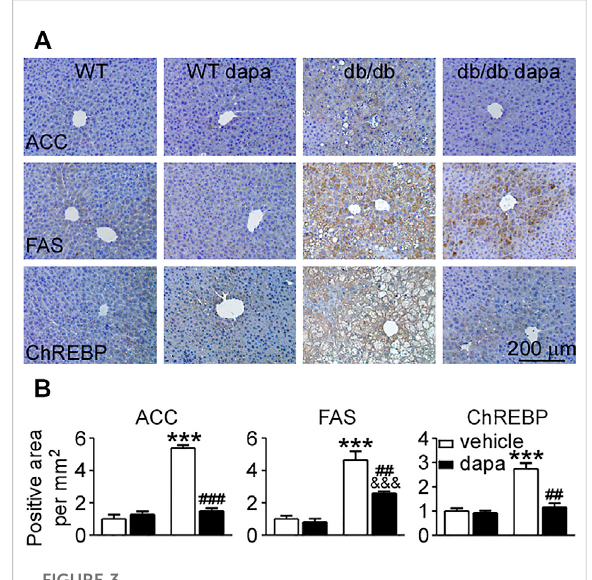
FIGURE 3 Dapagli fl ozin inhibited DNL in the liver of db/db mice. (A) Immunohistochemistry of ACC, FAS, and ChREBP in liver tissues. (B) The relative level of integrated optical densities (IODs) of ACC, FAS, and ChREBP. Values were mean ± SEM, n = 3. * p < 0.05, ** p < 0.01, and *** p < 0.001 vs. wild-type (WT) mice. # p < 0.05, ## p < 0.01, and ### p < 0.01 vs. db/db mice. & p < 0.05, && p < 0.01, and &&& p < 0.001 vs. dapagli fl ozin-treated wild-type mice. One- way ANOVA, Bonferroni ’ s multiple comparison test. DNL = de novo lipogenesis; FAS = fatty acid synthase; ACC =